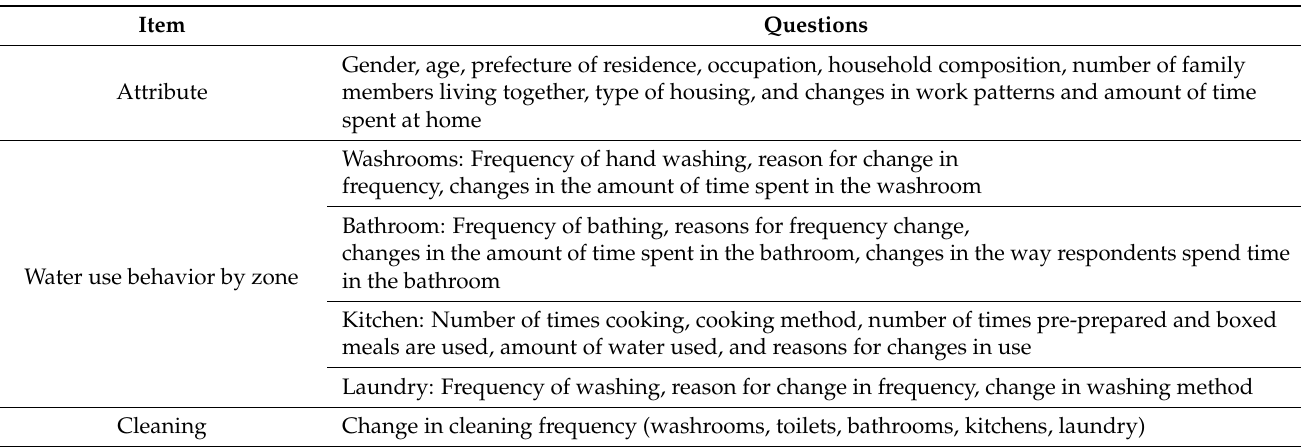
Table 2. Structure and questions.